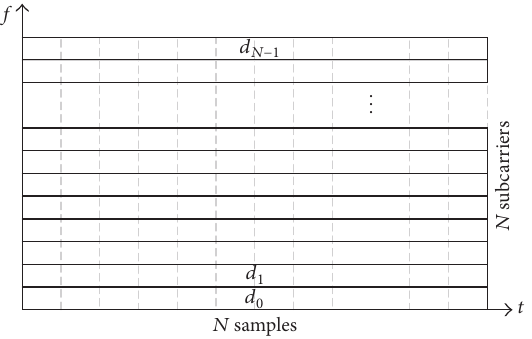
Figure 1: OFDM symbol mapping structure.